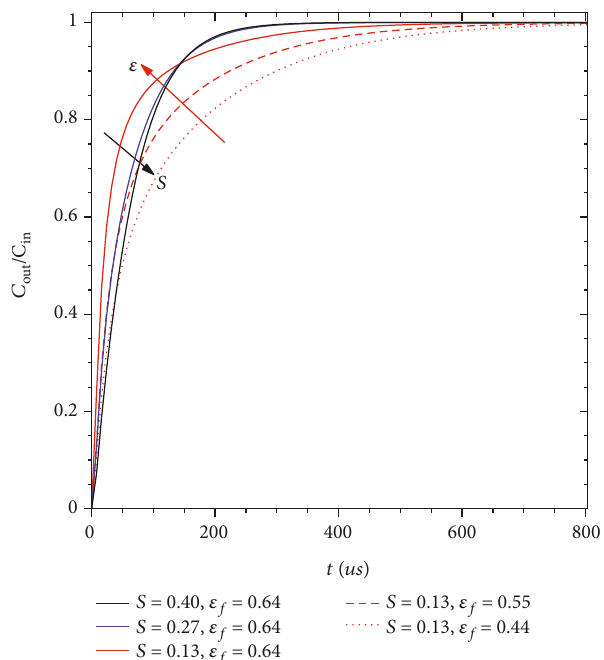
Figure 4: Results of the normalized output concentration for methane migration in porous media with adsorption under di ff erent porosities and speci fi c surface areas, respectively. Note that the total output concentration C out is normalized by the input concentration C in , and C in = C 0 H